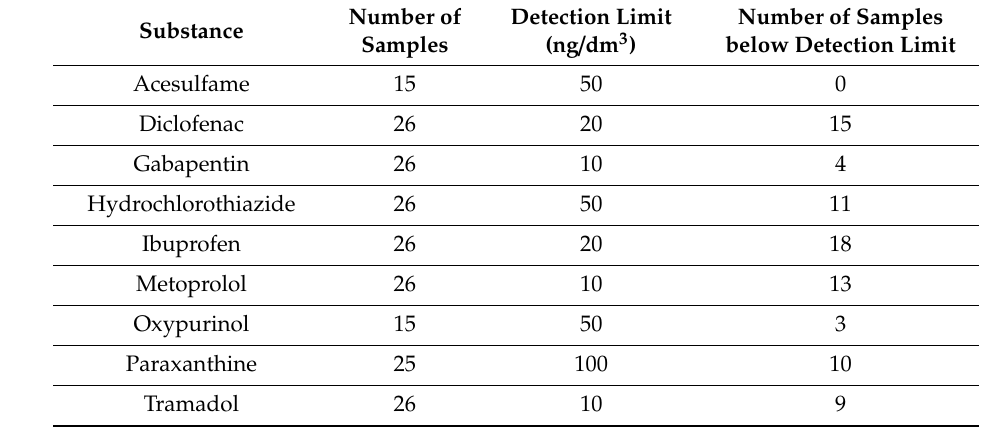
Figure 6. Monitoring results on Kacerov profile (flow rates data [41]). Table 9. Kacerov Profile—number of samples